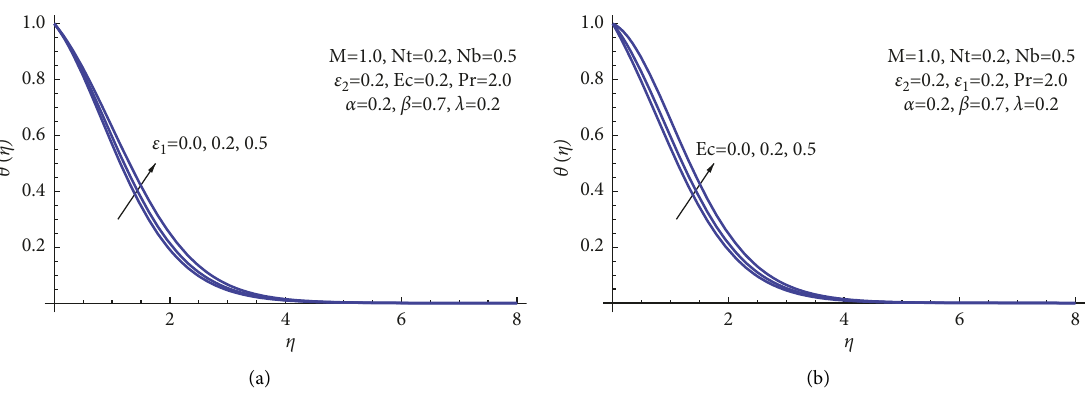
on θ ( η ) . (b) Impact of Ec on θ ( η ) 1